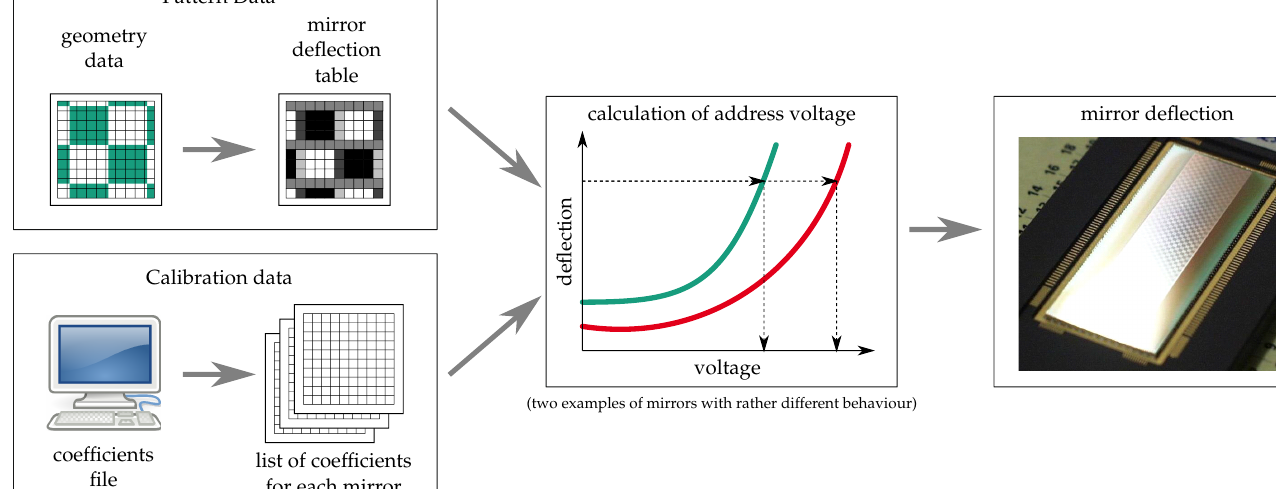
Figure 9. Schematic representation of the calibration procedure as described in